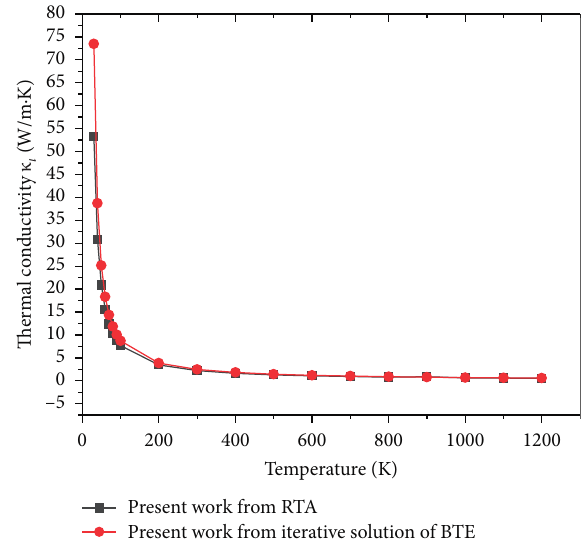
Figure 5: The phonon scattering rates of monolayer CaHBr at room temperature. The orange star is for the optic modes.